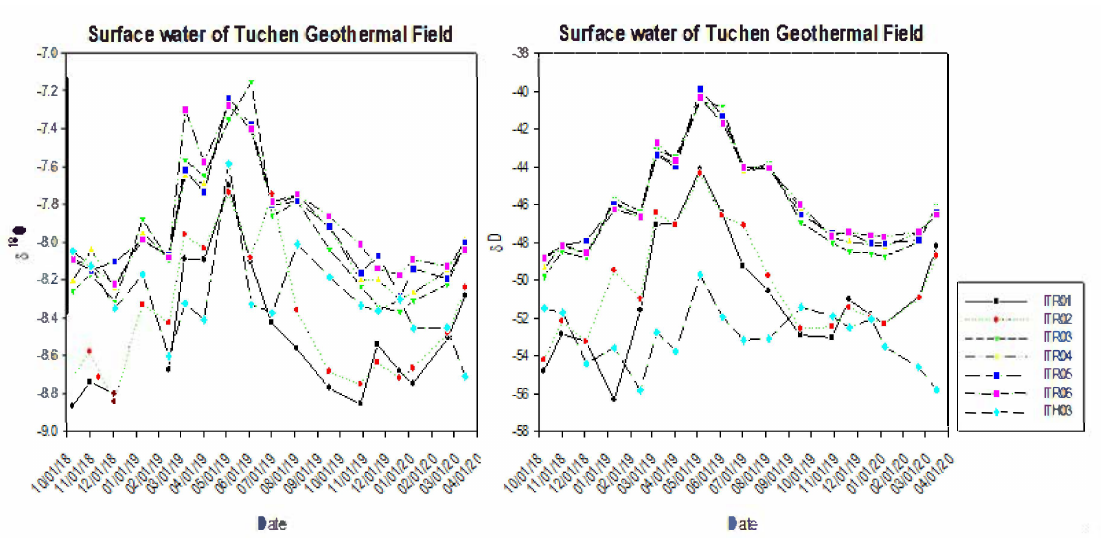
Figure 5. Time series of δ 18 O and δ D variations of surface water in the study area. ITR01 and 02 are clearly lighter than the rest group due to belonging to different tributaries. However, two sets of data show the same pattern, peak, and heavier values between Mach and July.